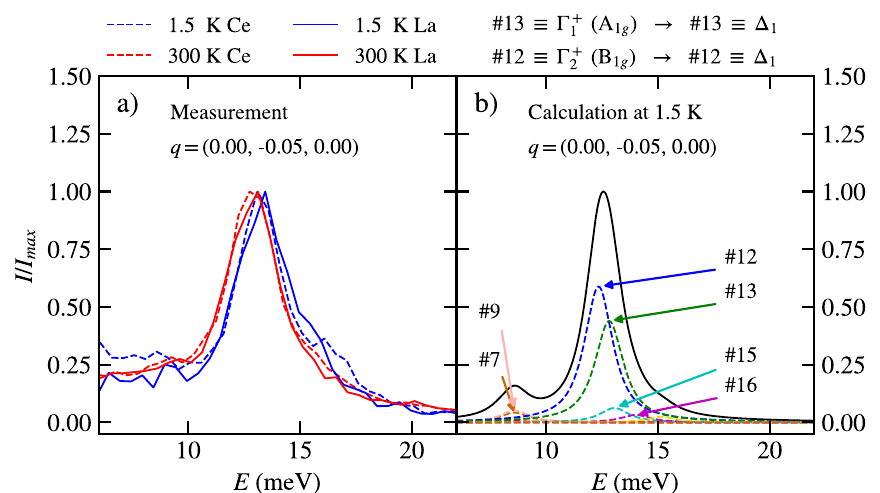
0.05, 0.00 ) ) temperatures ( 0.00, = −